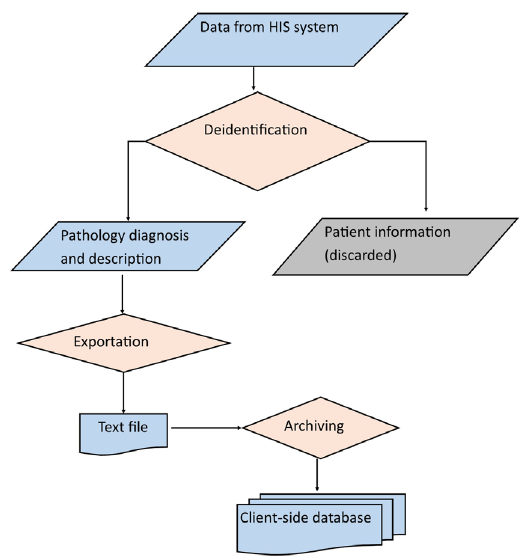
Figure 1: Data retrieval and pre-processing